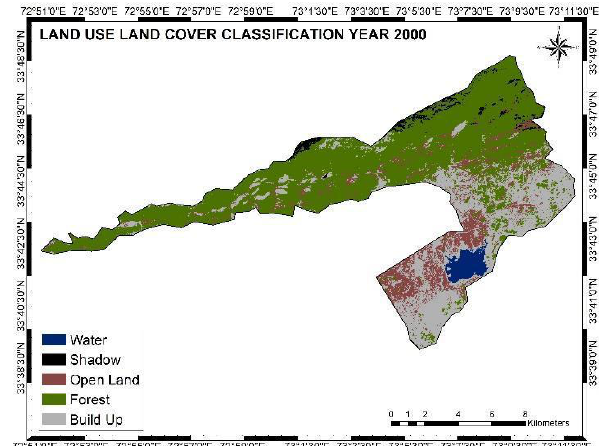
Figure 2: Land Use/ Land Cover Supervised Classification Margalla Hills National Park (MHNP) Year 2000 Islamabad, Pakistan.